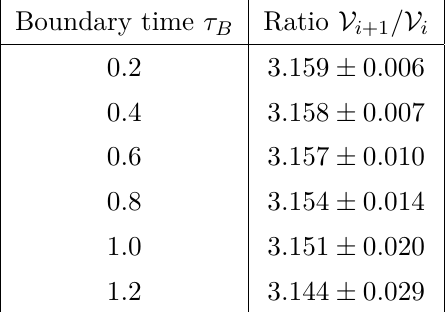
total volume from the contribution coming only from the leading divergence. One can verify that at τ = 0 the analytic result in eq. (5.14) for the BTZ background is recovered B with great